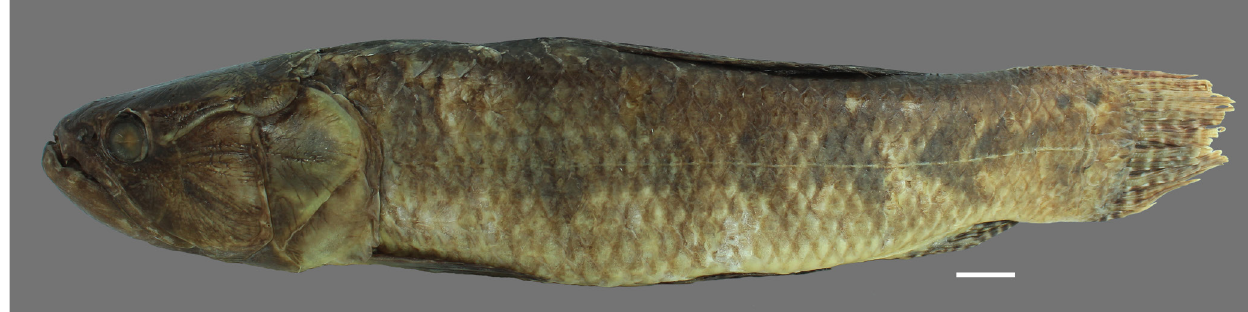
FIGURE 1 | Hoplias misionera , UFOPA AMTRA131-19, 237 mm SL, Amazonas River, Alenquer, Pará, Brazil. Lateral view. Scale bar = 1 cm. Photo by L.R.R.